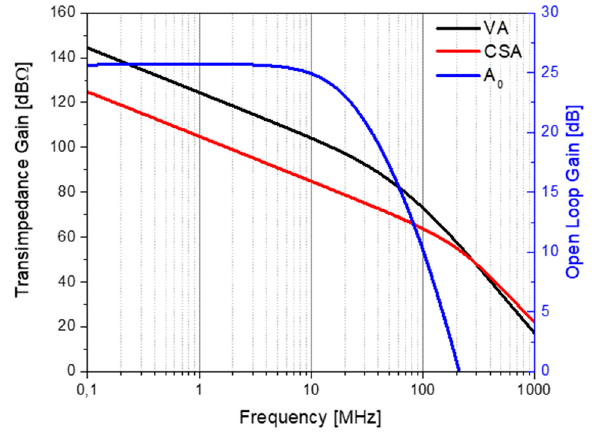
Figure 8. Frequency response of both amplifiers (VA and CSA) (left axis) along with the push–pull open-loop response of A 0 (right axis).